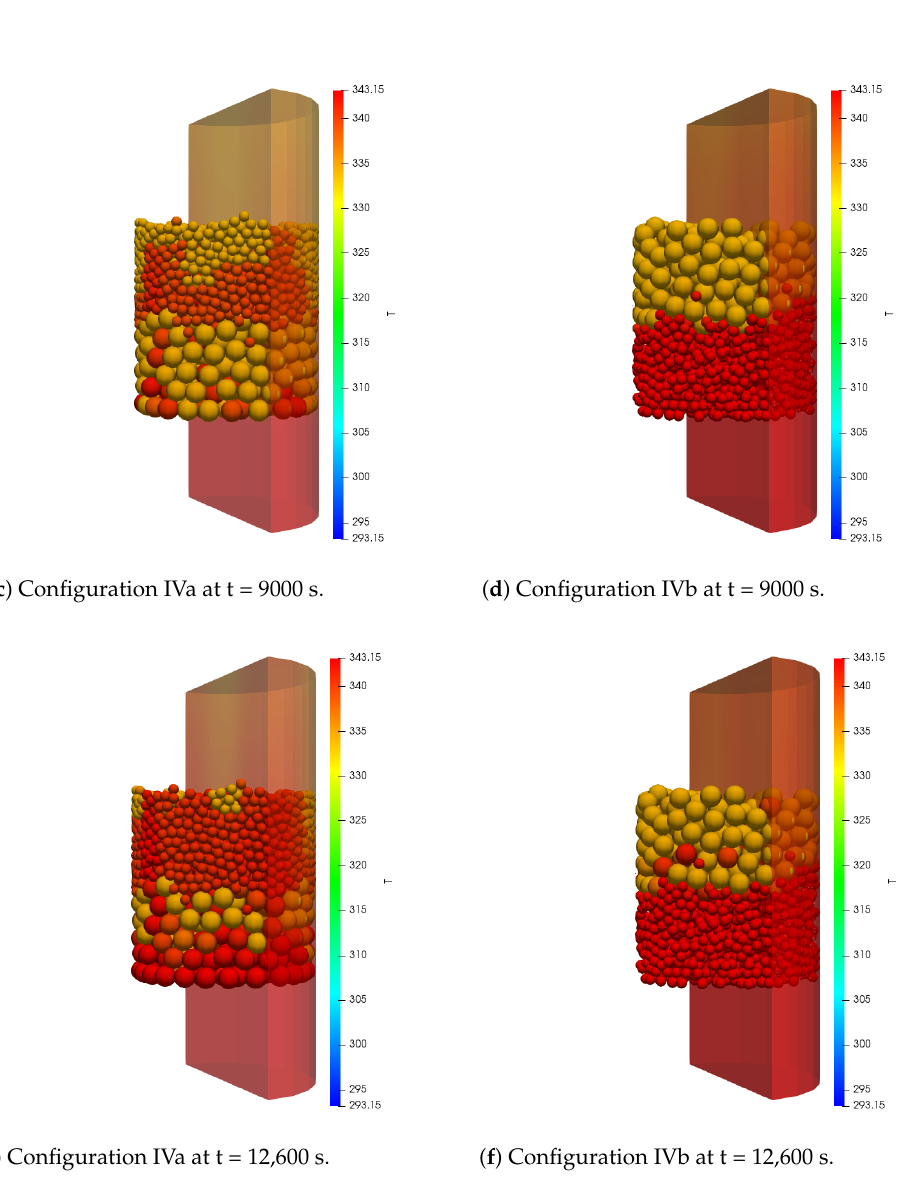
Figure 10. Comparison of temperature for both versions of Configuration